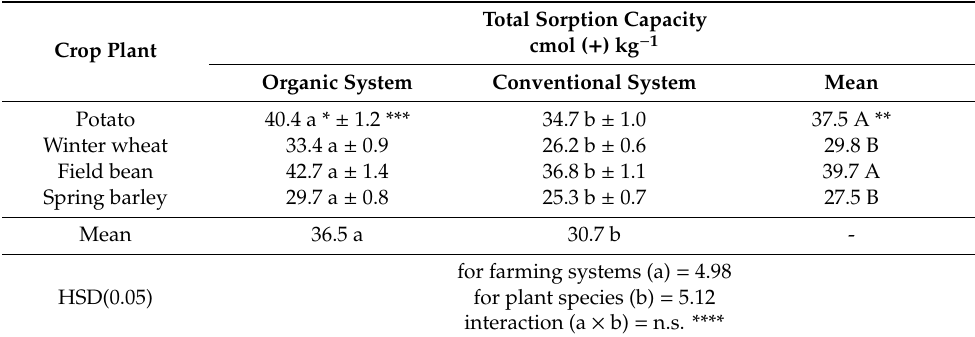
Table 9. Total sorption capacity of soil in the 0–25 cm soil